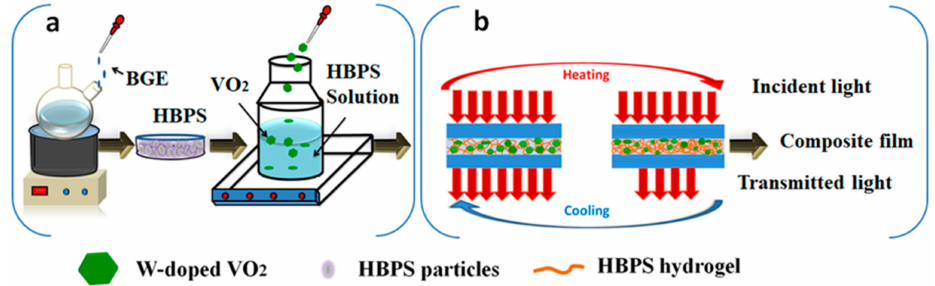
Figure 3. ( a ) The schematic illustration of the preparation of W-doped VO 2 / HBPS composite; ( b ) The structure and working principle of our hybrid thermochromic film. Solar light is mostly transmitted at lower temperatures (left) and partially blocked at higher temperatures